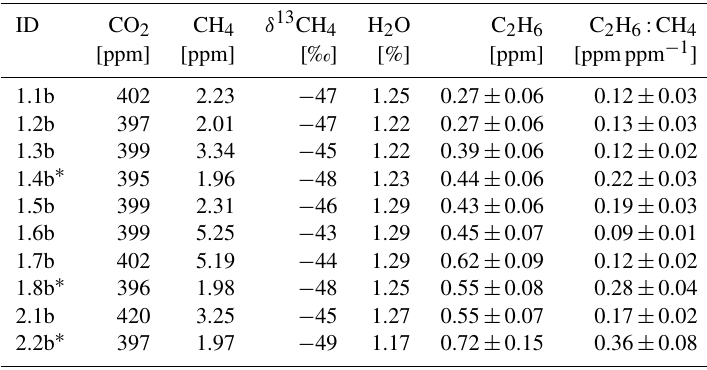
Table C1. C 2 H 6 : CH 4 with interference correction for high